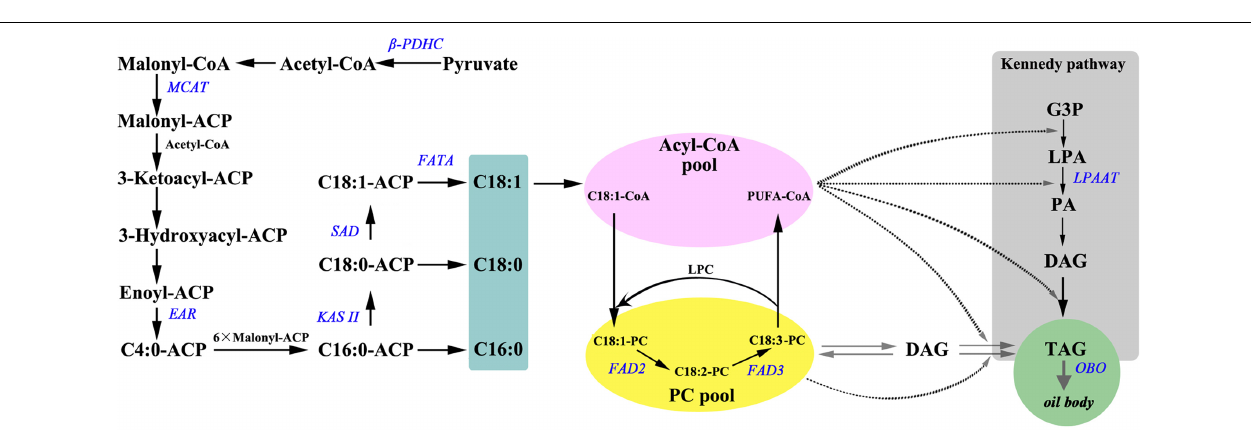
FIGURE 4 | An overview of (A) major genes involved in fatty acid synthesis and triacylglycerol assembly. Substrates are in bold: ACP, acyl carrier protein; DAG, diacylglycerol; G3P, glycerol-3-phosphate; LPA, lyso-phosphatidic acid; LPC, lyso-phosphatidylcholine; PA, phosphatidic acid; PC, phosphatidylcholine; PUFA, polyunsaturated fatty acids; TAG, triacylglycerol. Enzymatic reactions are in bold italics: β -PDHC , pyruvate dehydrogenase beta subunit; MCAAT , malonyl-CoA:ACP transacylase; EAR , enoyl-ACP reductase; KAS II, ketoacyl-ACP synthase II; SAD , stearoyl-ACP desaturase; FAD3 , (cid:49) 15 ( ω -3) linoleic acid desaturase; FATA , acyl-ACP thioesterase A; FAD2 , (cid:49) 12 oleic acid desaturase; LPAAT , 1-acylglycerol-3-phosphateacyltransferase; OBO , oil-body oleosin.